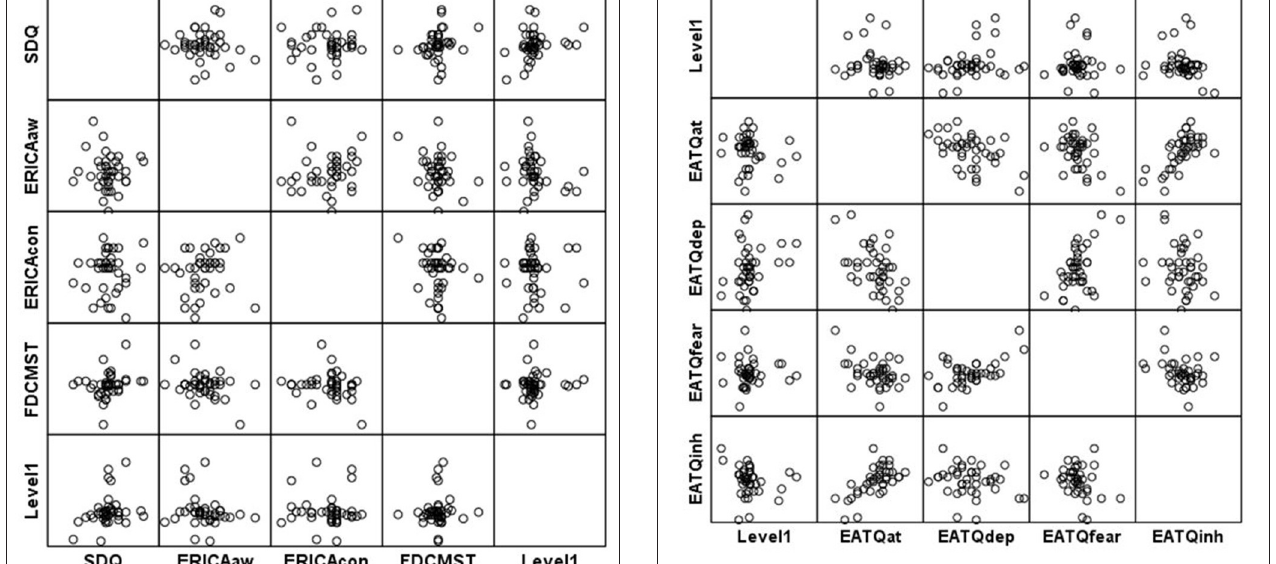
included in the main study was α = 0.80 for functional negative emotions subscale, α = 0.65 for dysfunctional negative emotions subscale, and α = 0.66 for positive emotions subscale.